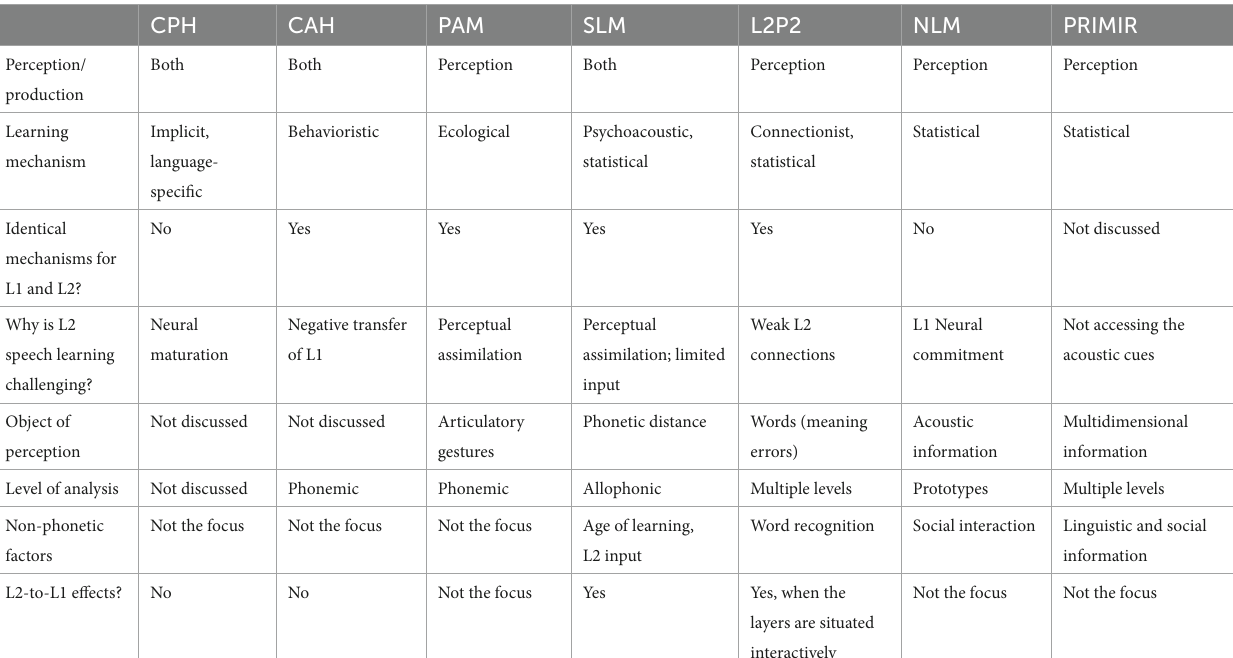
TABLE 1 A summary of the speech development theories